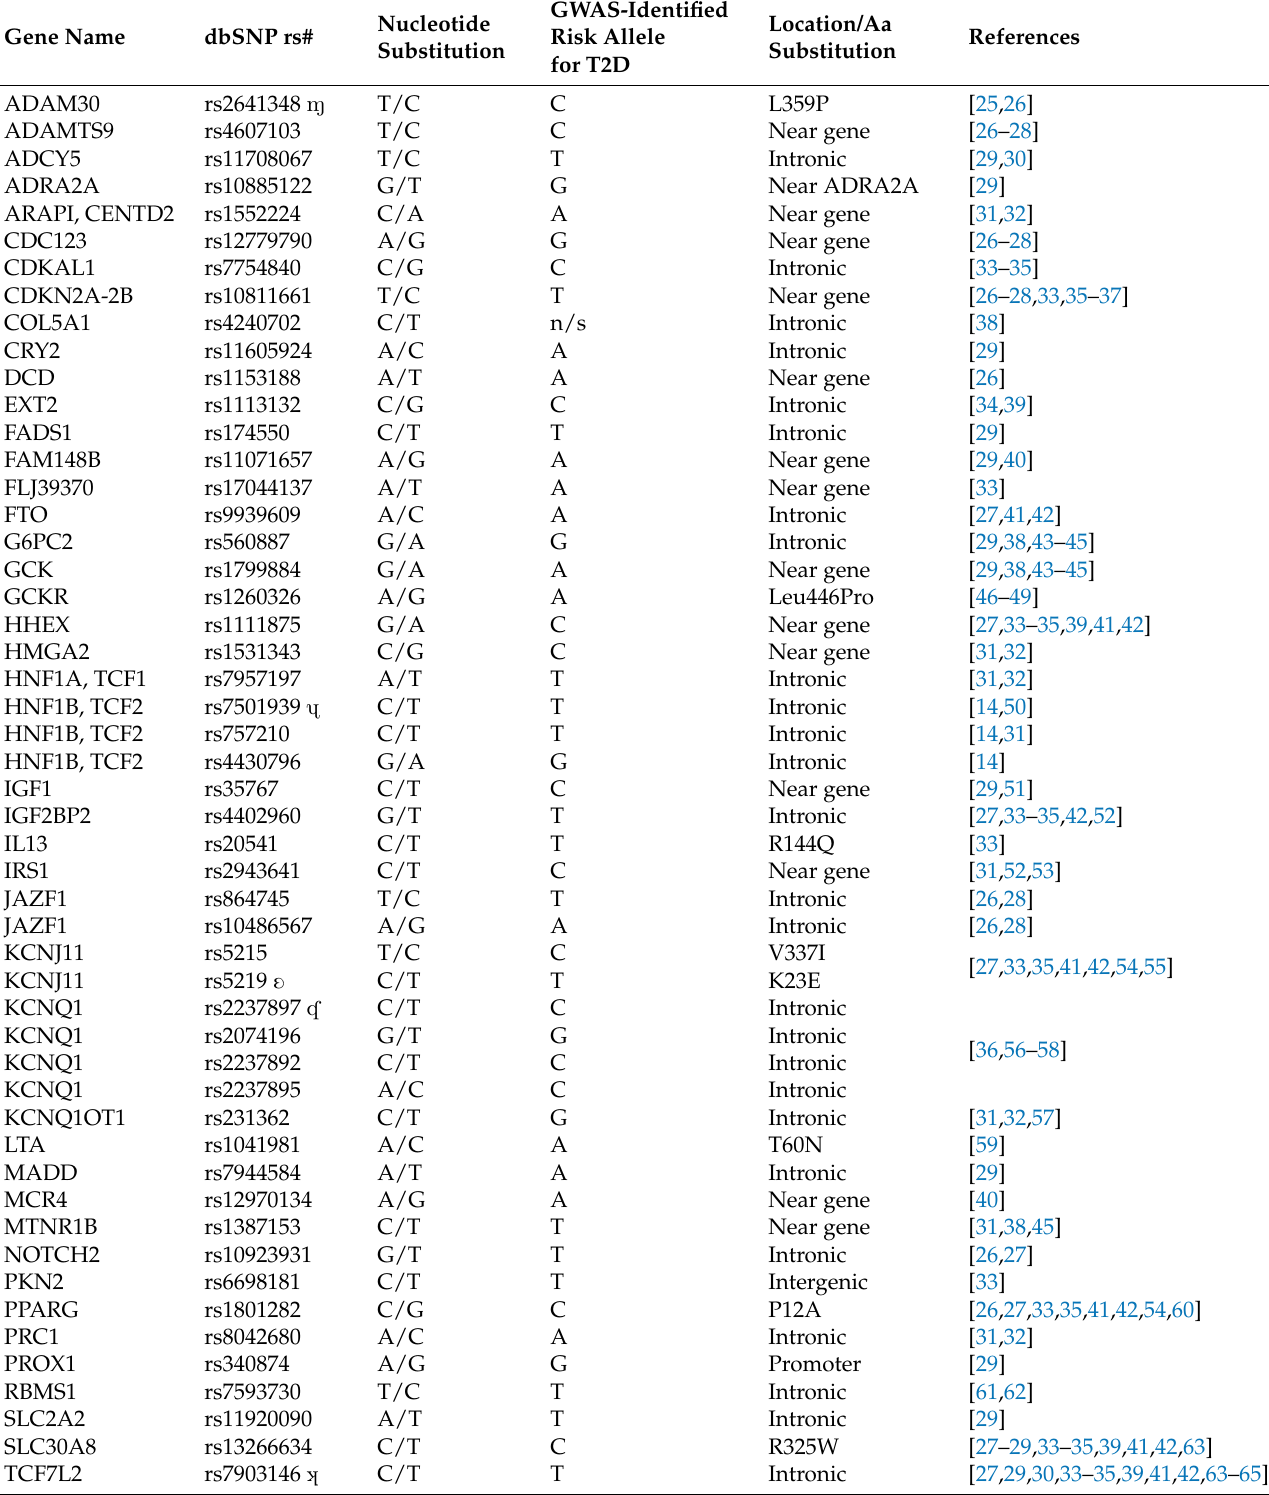
Table 2. Selected type 2 diabetes-related